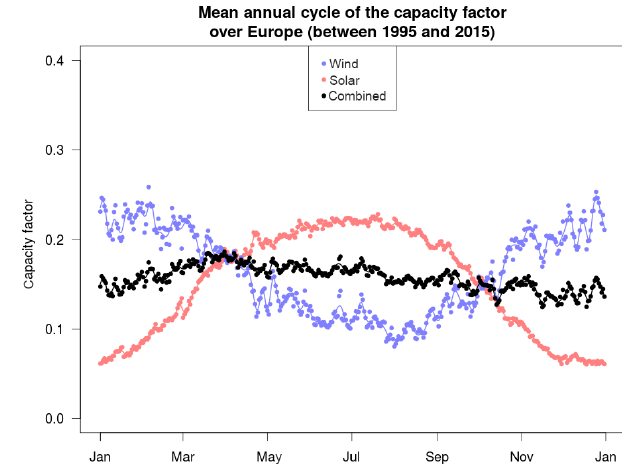
Figure 5. Seasonal cycle of the capacity factors for wind and PV for Europe, otherwise same as Fig. 4.